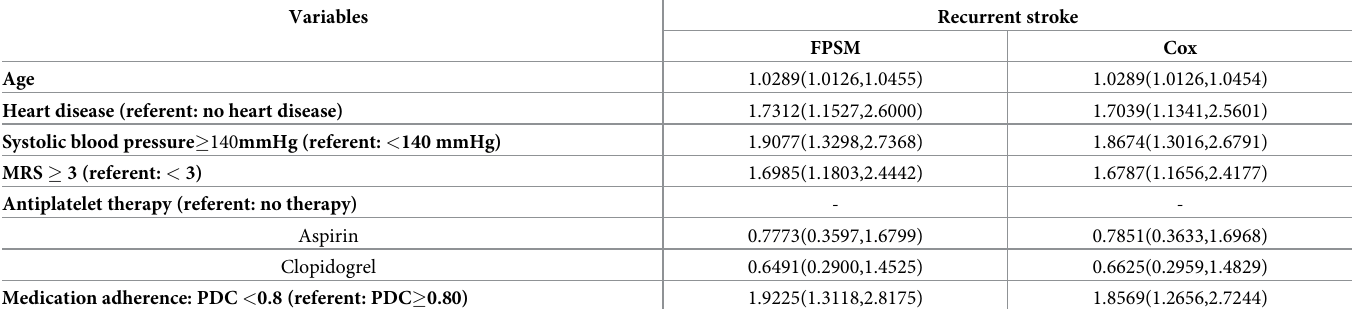
Table 3. Hazard ratios (95% confidence intervals) of the flexible parametric survival model (FPSM) and Cox proportional hazards model (Cox).